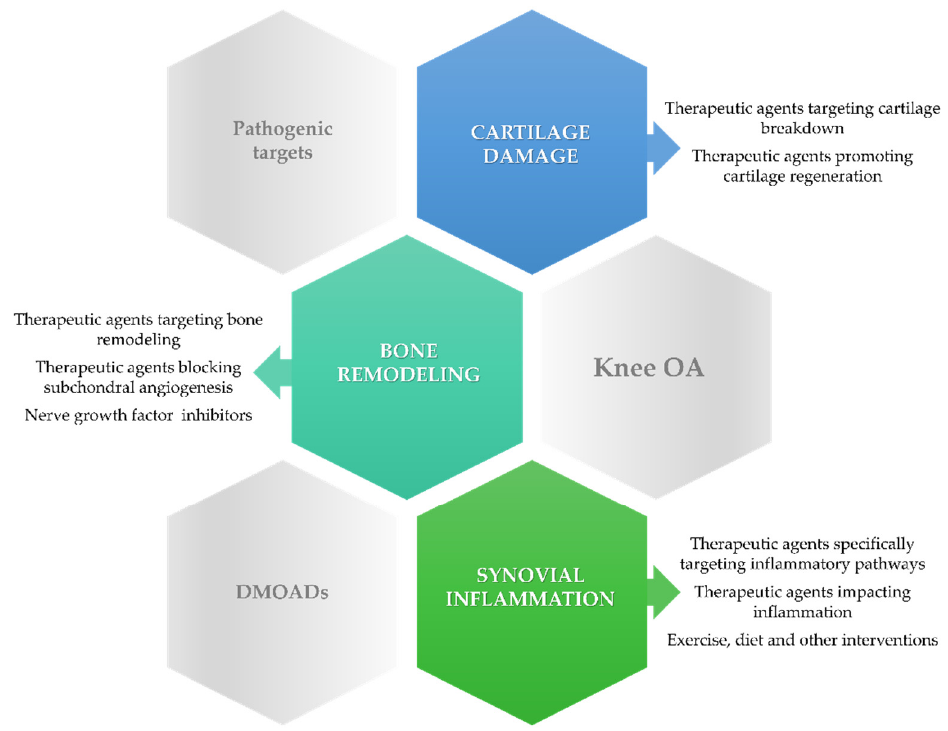
Figure 1. Therapeutic interventions targeting cartilage breakdown, bone remodeling, and inflam- mation in knee osteoarthritis (OA).